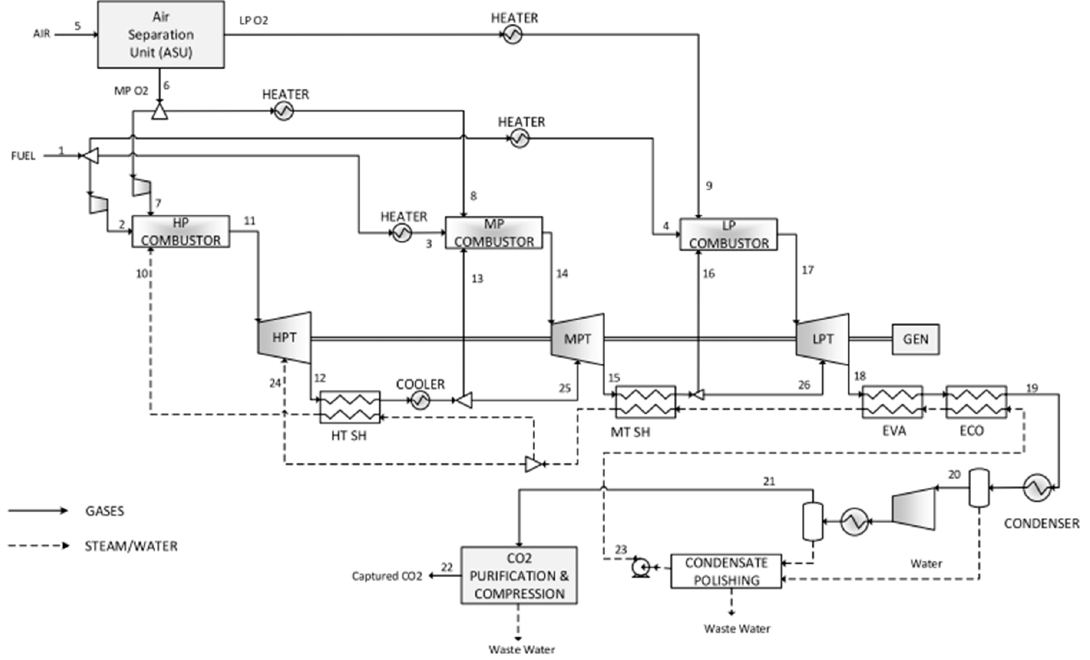
Figure 15. Distribution of the thermal energy input within the Allam cycle. The figures across the chart represent the percentage of the thermal input.